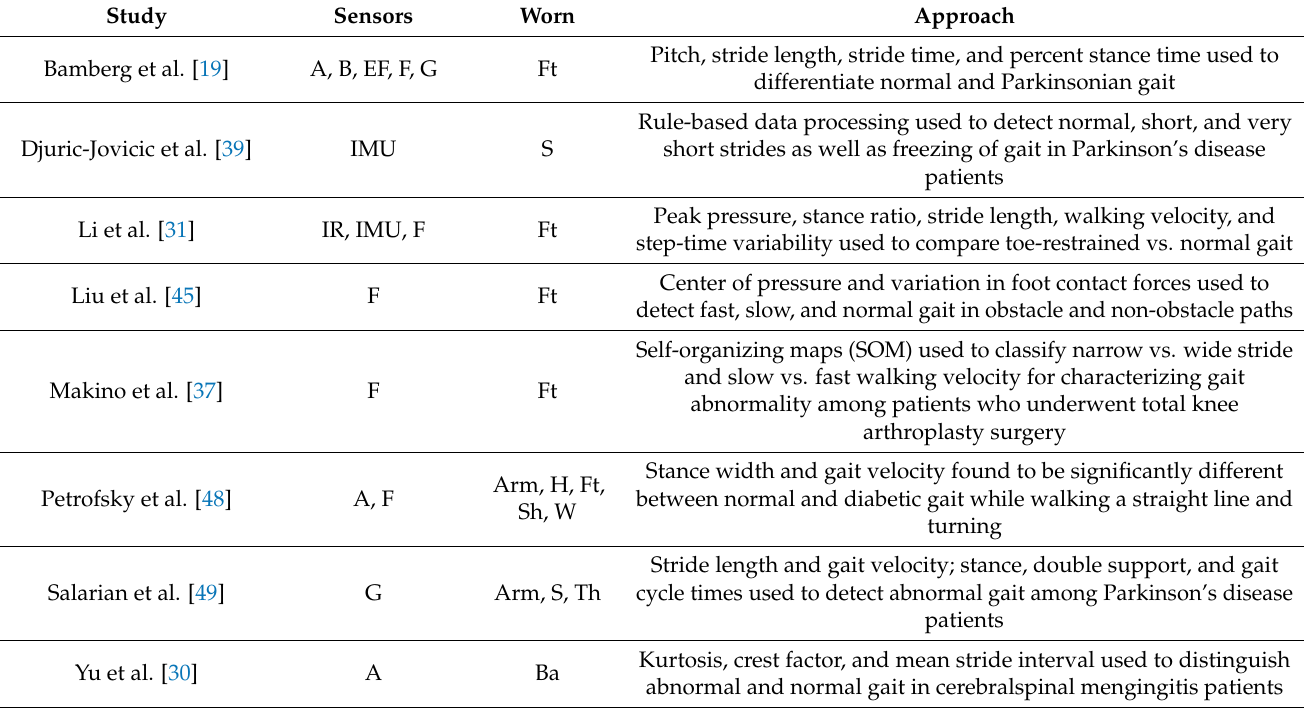
Table 2. Wearable Sensors Used to Detect Abnormal